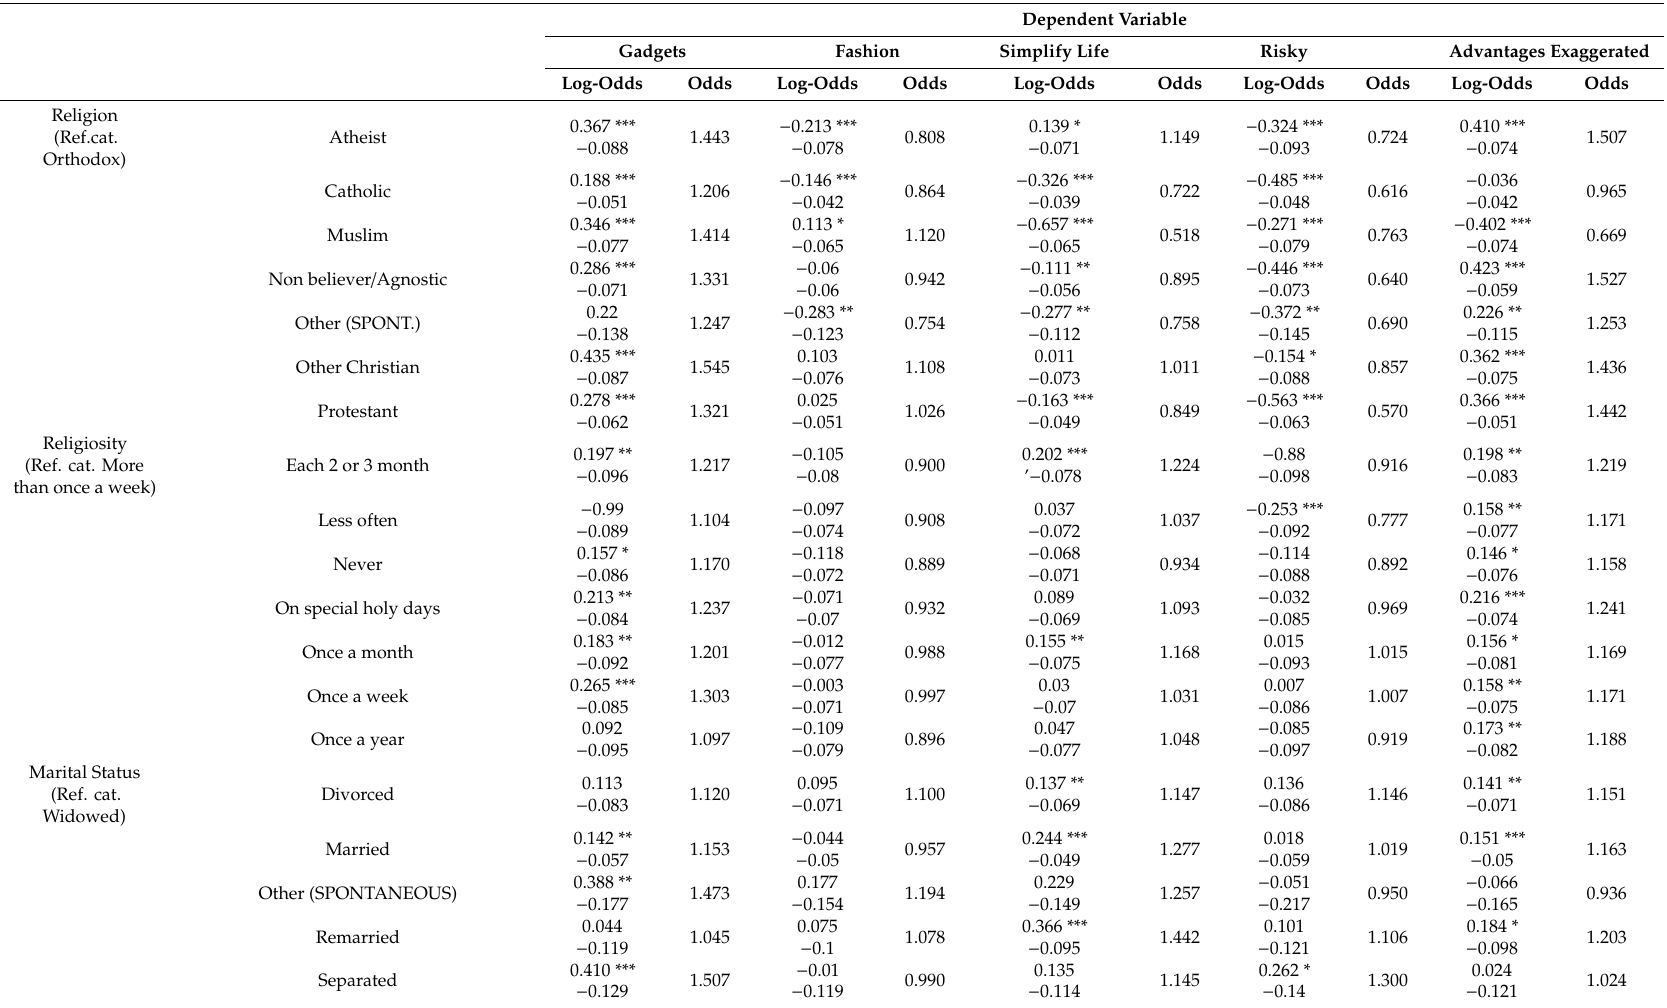
Table 5. Logistic Regression Results on Innovation